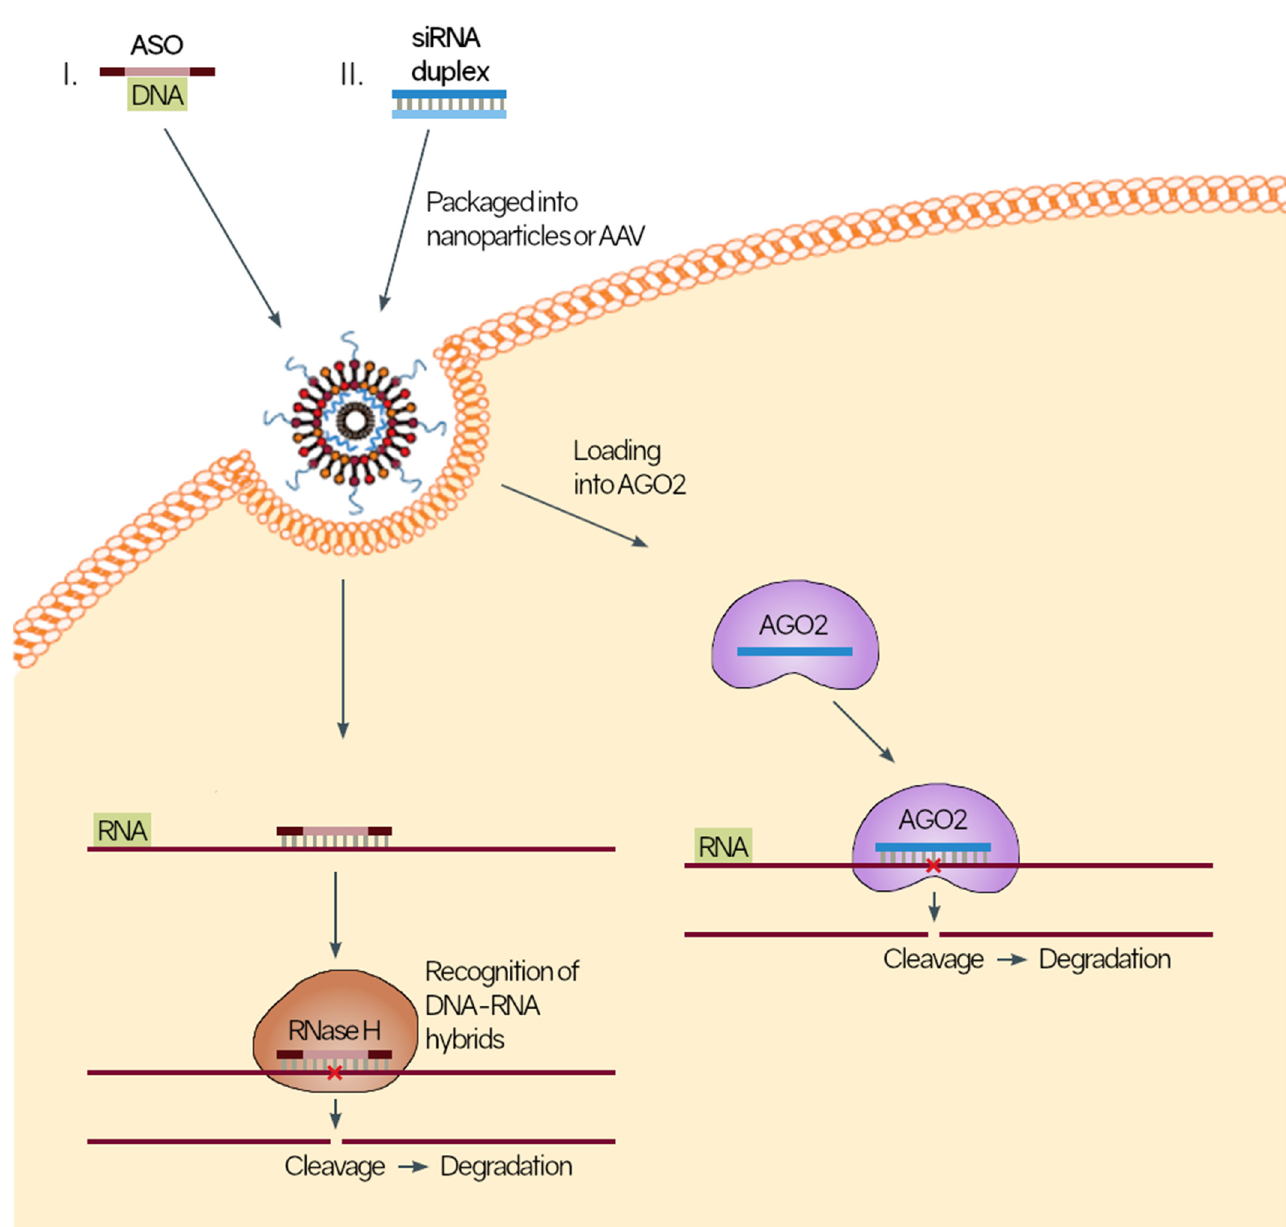
Figure 1. Mechanisms of mRNA transcript regulation. I. Anti-sense oligonucleotides (ASO) or II. Small interfering RNA (siRNA) duplexes are packaged into nanoparticles or adeno-associated viruses (AAV) that allow them to pass through the lipid bilayer. Once inside, ASOs can bind to the complementary messenger RNA (mRNA) strands. These DNA-RNA hybrids are recognized by RNAse H, leading to cleavage and degradation of the transcript, X, indicates where RNAse H is binding. siRNA duplexes loaded into Argonaute 2 (AGO2) to form an RNA-induced silencing complex that can bind to complementary mRNA strands, leading to cleavage and degradation of the transcript. Both pathways lead to significant downregulation of gene expression.